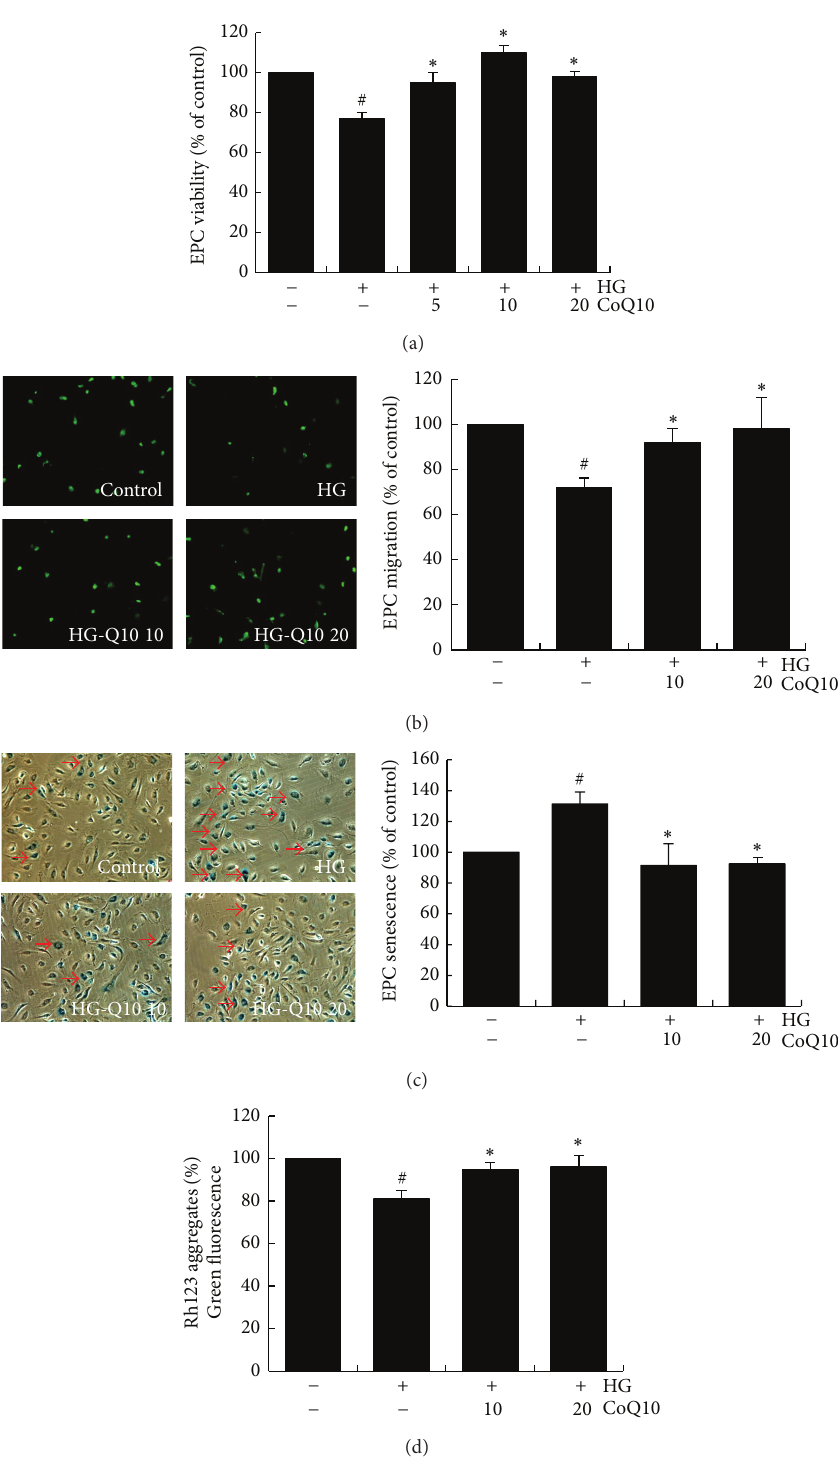
Figure 2: Effects of CoQ10 on EPC viability, migration, senescence, and mitochondrial function under high glucose conditions. Cells were cultured with glucose (25 mM) for 3 days, followed by treatment with CoQ10 (5 𝜇 M, 10 𝜇 M, and 20 𝜇 M) for 24 hr. (a) EPC viability was analyzed by MTT assay. (b) A Boyden chamber assay was used with SDF-1 as chemoattractive factor for EPC migration. The migrated cells were stained with fluorescein isothiocyanate UEA-1 (lectin) (green) and counted under the fluorescence microscope. (c) EPC senescence was analyzed by senescence-associated acidic- 𝛽 -galactosidase activity assay. (d) Cell mitochondrial function was measured by staining with rhodamine 123- (Rh123-) derived green fluorescence 5mM for 20 min. Data are mean ± SE; 𝑛 = 6 ; # 𝑃 < 0.05 versus control (5 mM glucose); ∗ 𝑃 < 0.05 versus high glucose